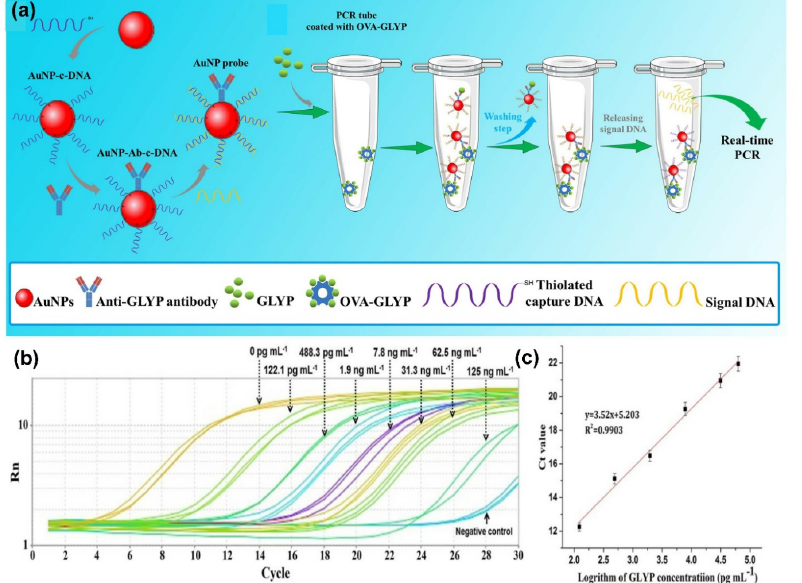
Figure 12. Schematic illustration of the AuNP-BB-iPCR. ( a ) Synthesis procedure of the AuNP probe. ( b ) Amplification curves of real-time PCR for the standard curve of Ct value against concentrations of signal DNA (from 1 fM to 0.01 µM). Water was used instead of signal DNA for negative control. ( c ) The standard curve of Ct values against logarithm concentrations of signal DNA. Reprinted with permission from [130]. Copyright 2021 Elsevier.